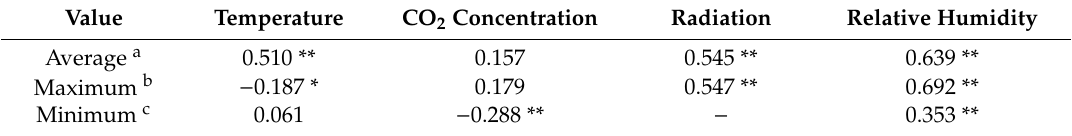
Table 3. Correlation analysis of time series variables in growth and environment factors.